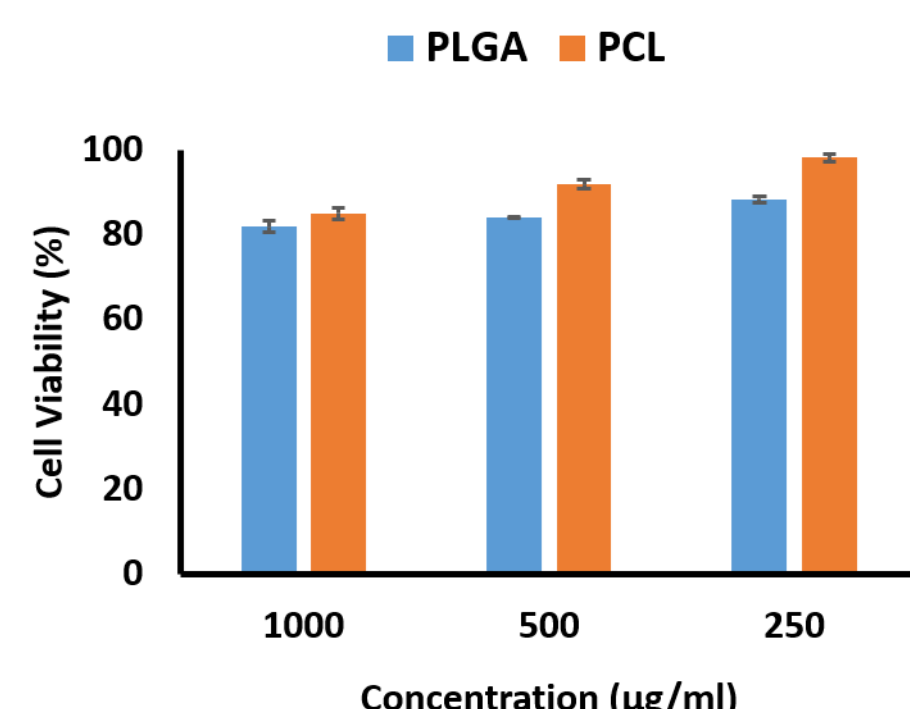
Figure 5. Cell viability percentages of PCL and PLGA nanofibers at different concentrations (250–1000 µg/mL).